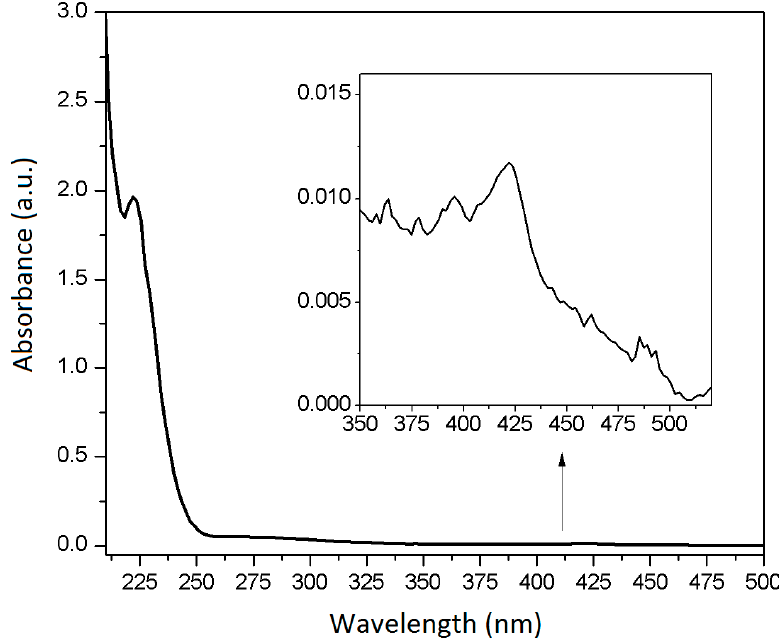
Figure 5. UV-VIS absorption spectrum (wavelength from 210 to 500 nm) of babassu oil diluted in hexane at 0.0100 g L − 1 ). Inset: Zoom of the UV-Vis spectrum in the 350 to 500 nm range.